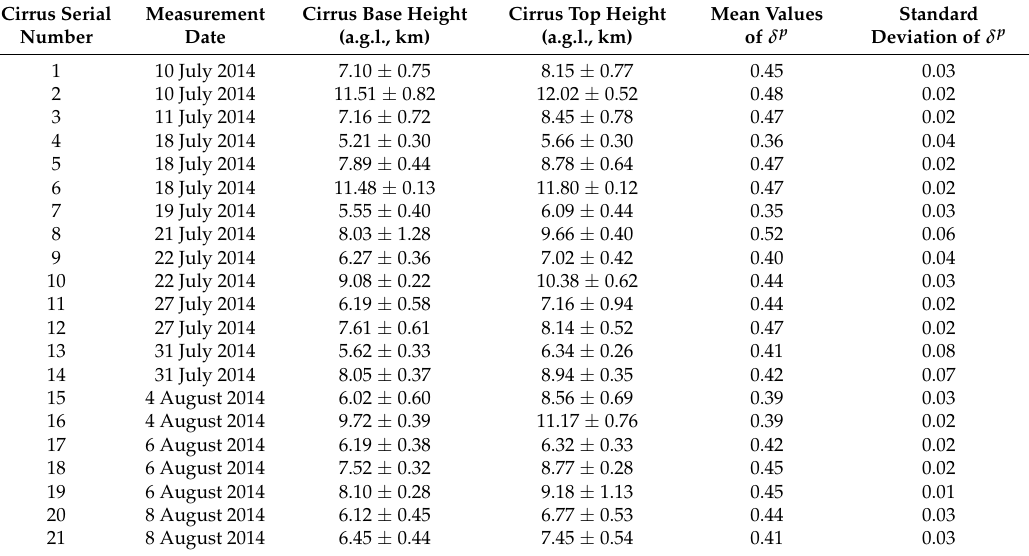
Table 4. Heights and depolarization ratio of cirrus measured in